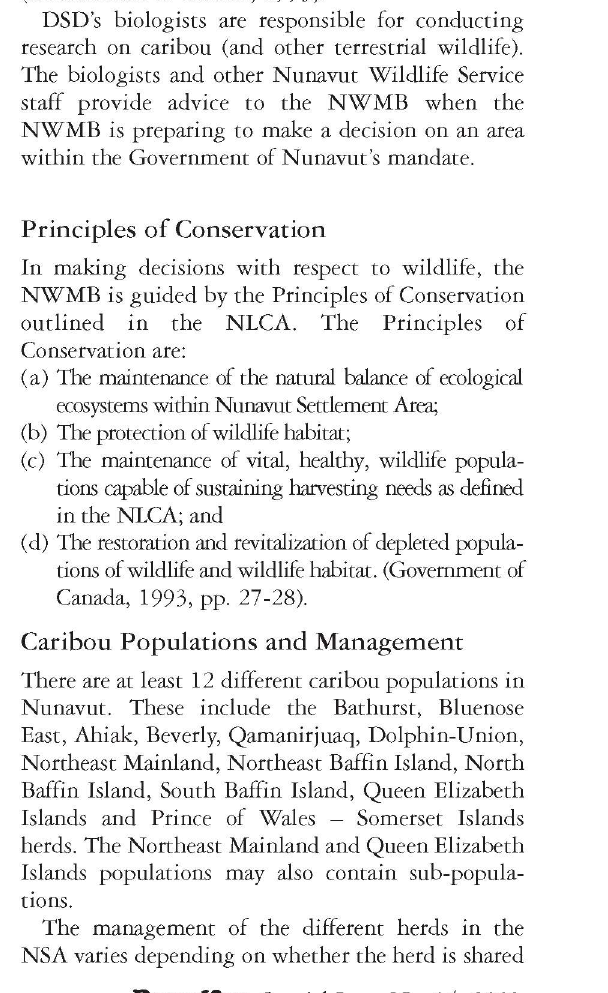
Fig. 1. Map showing the Territory of Nunavut within Canada. The Nunavut Settlement Area (NSA) includes all of the Territory of Nunavut except for Hudson Bay and the southern part of Hudson Strait, but does also include the Belcher Islands in Hudson Bay. Maps courtesy of www.theodora.com/maps, used with permission. members choose the independent chairperson. The sents the public in